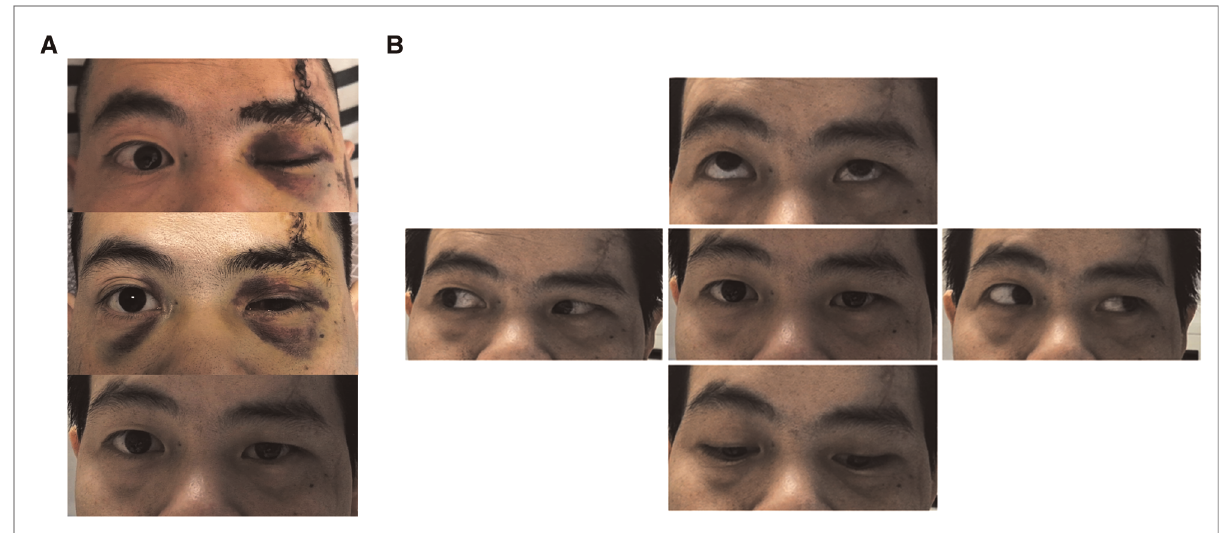
FIGURE 6 Changes in ptosis symptoms and eyeball movement 1 month after surgery. ( A ) Change in preoperative and postoperative ptosis symptoms: before surgery, 3 days after surgery and 1 month after surgery from top to bottom. ( B ) Upward, downward, leftward and rightward movement of the eyeball 1 month after